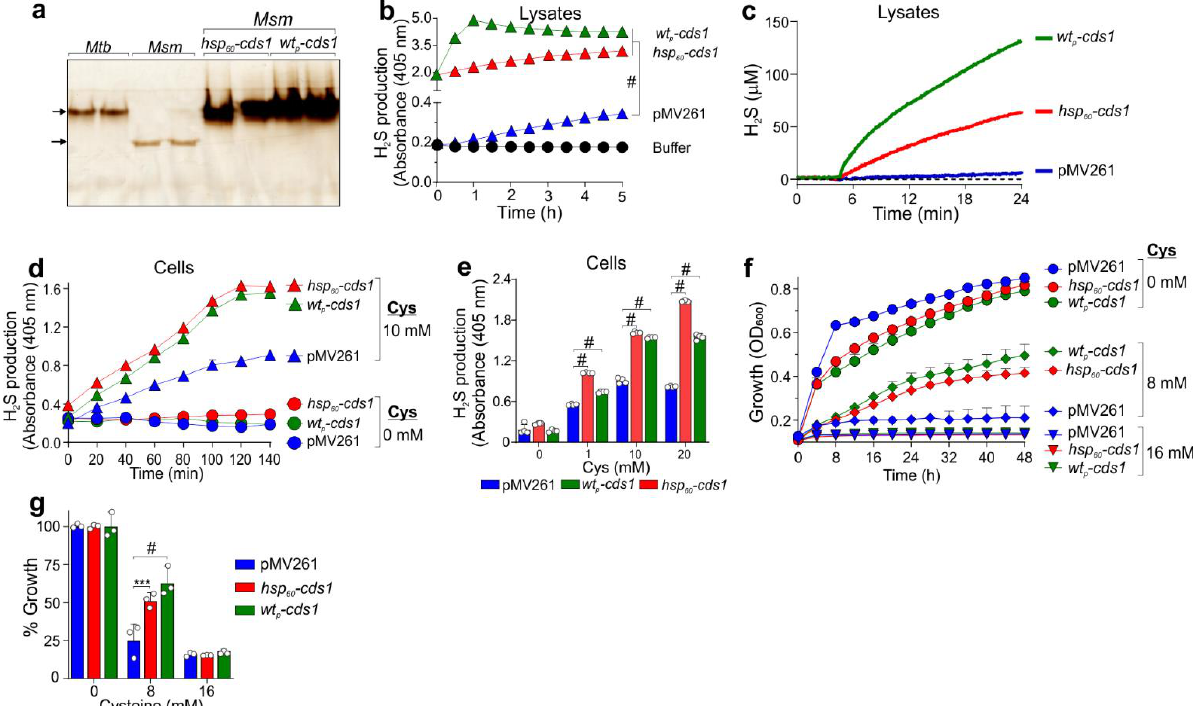
Figure 4. Conferring H 2 S-producing activity to M. smegmatis . ( a ) Equal quantities of bacterial lysates from Mtb H37Rv, Msm , and cds1 -expressing Msm–wt p – c ds1 and Msm–hsp 60 – c ds1 cells were resolved on native polyacrylamide gels (PAGE) and assayed for H 2 S production using an in-gel BC assay, ( n = 2). ( b ) BC assay of H 2 S production in Msm lysates. pMV261- Msm transformed with an empty pMV261 vector ( Msm -pMV261) and a buffer–lysate suspension buffer and BC solution, ( n = 4). ( c ) H 2 S production in Msm lysates using the Unisense amperometric microsensor. The microsensor readings were allowed to measure a buffer baseline for 5 min followed by addition of the lysate to initiate the reaction. ( d ) Time course of H 2 S production in intact Msm cells in the presence of 0 and 10 mM L-Cys in the BC assay, ( n = 4). ( e ) H 2 S production in intact Msm cells in the presence of 0, 1, 10, and 20 mM L-Cys after 140 min in the BC assay, ( n = 4). ( f ) Growth kinetics (OD 600 ) of Msm strains in Cys-containing media, ( n = 3). ( g ) Relative percent growth of Msm strains in L-Cys-containing media after 48 h, ( n = 3). Representative experiments are shown; each experiment was repeated at least twice. Data represent the mean ± SD or ± SEM ( d , f ) from the indicated n (number of replicates per data set). Statistical analysis was performed using GraphPad Prism 8.4.3. One-way ANOVA ( b ) and two-way ANOVA ( d , f ), and Dunnett’s multiple comparisons test were used to determine statistical significance. *** p < 0.001, # p <